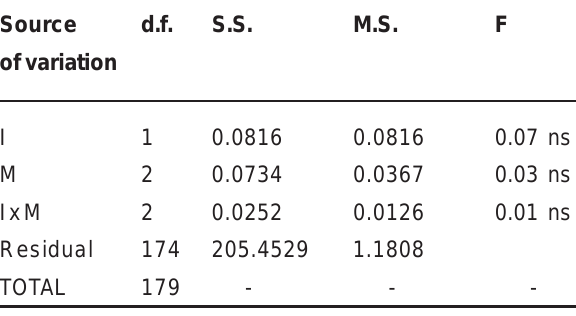
TABLE 2- Measurements from interpretation (I) and method (M) in two-way analysis of variance